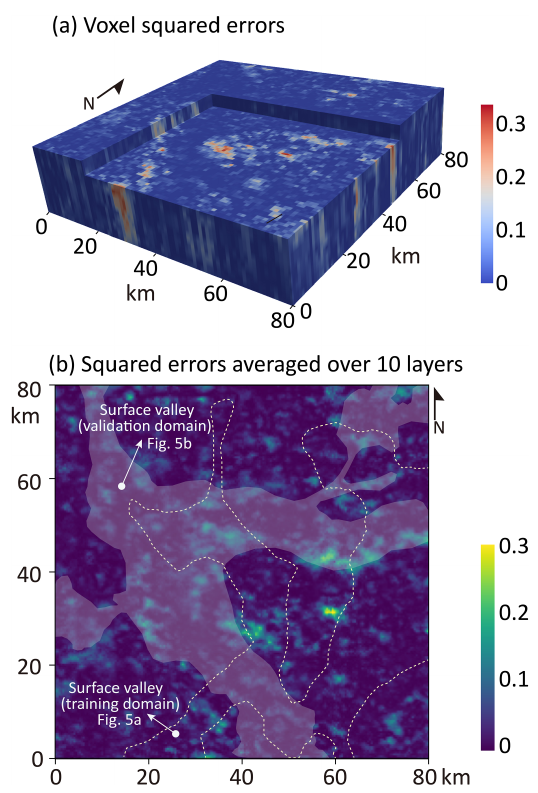
Figure 6. (a) The 3D distribution of squared errors between simu- lated PAI and real PAI in the validation domain and (b) plan view of the mean of squared errors from 10 layers, overlain by the surface (modern-day) valley (validation and training domains). The large errors, to some extent, focus on the edge of modern-day valley in the validation domain but are unrelated to the modern-day valley in the training domain, suggesting that the overfitting does not